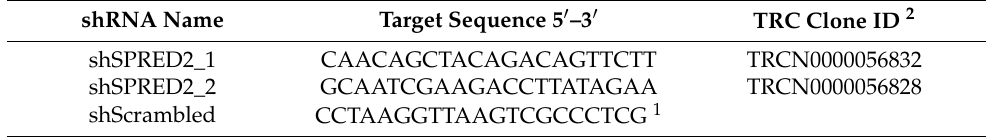
Table 1. shRNA target